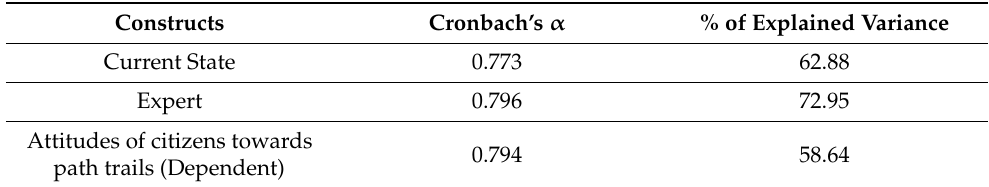
Table 5. Reliability and validity measures for latent constructs (factors) used in SEM analysis (Cronbach’s α , % of explained